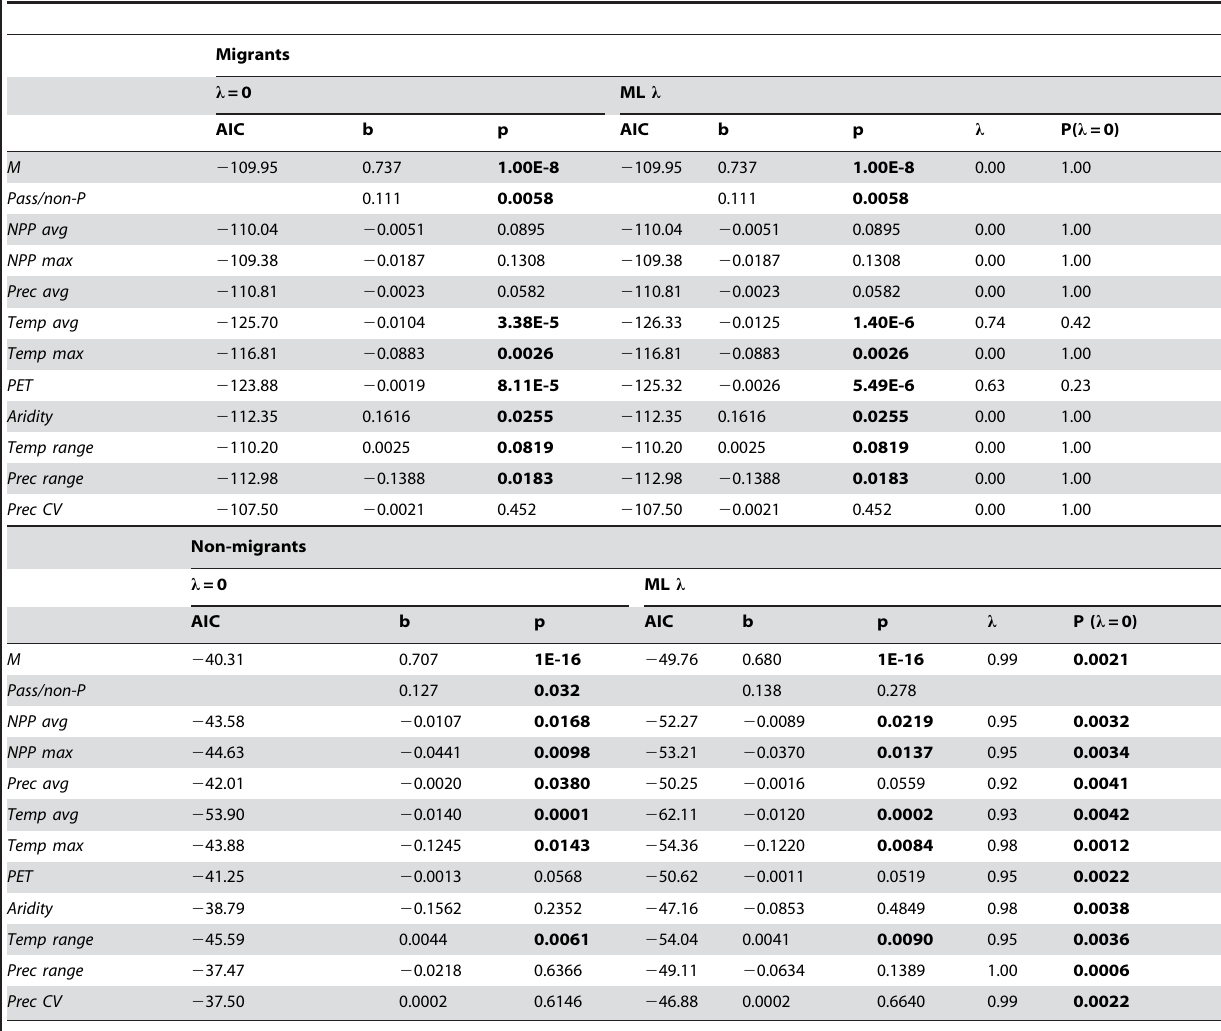
Table 4. Environmental correlates of BMR across migrants (a) and non-migrants (b) accounting for M and Pass/non-P.